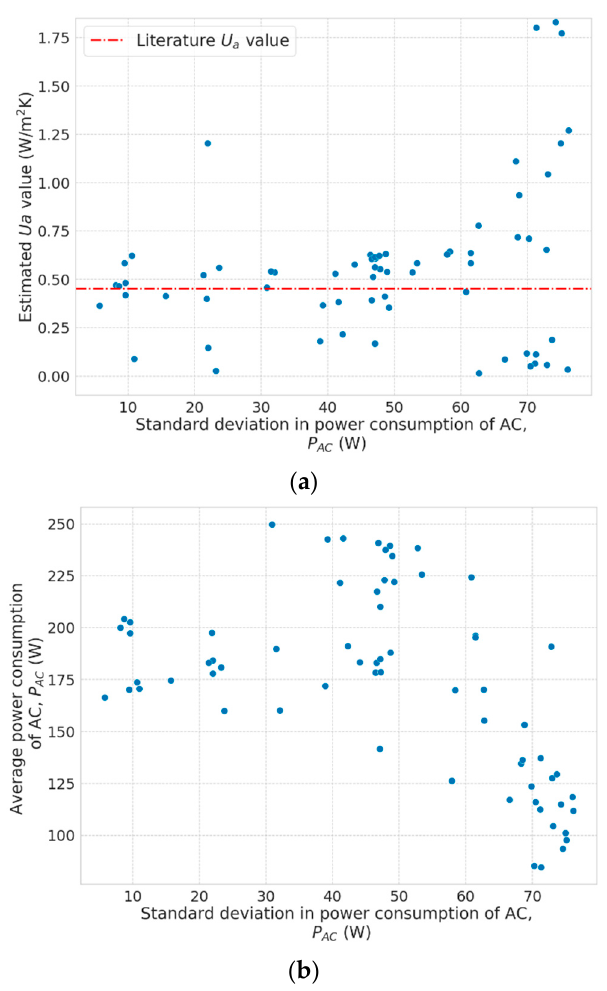
Figure 11. Impacts of AC operation on estimation accuracy: ( a ) Estimated U a values and standard deviation of P AC , ( b ) the relationship between average and standard deviation of P AC